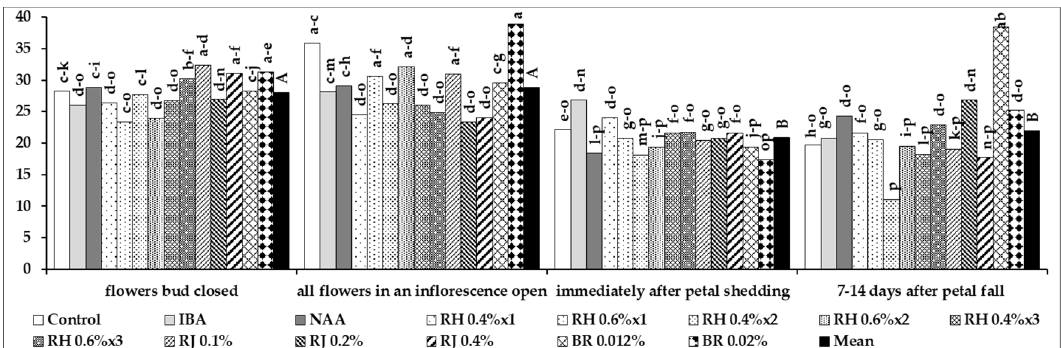
Figure 6. The influence of rooting enhancers on total leaf area (cm 2 ) in Rosa ‘Maiden’s Blush’ cuttings harvested in four phenological stages of shoot. Control—the control cuttings; IBA 0.4%—Ukorzeniacz A aqua (0.4% IBA); NAA 0.2%—Ukorzeniacz B aqua (0.2% NAA); RH 0.4%×1, RH 0.6%×1—watering with 0.4% or 0.6% Bio Rhizotonic (10 mL) after planting; RH 0.4%×2, RH 0.6%×2—watering with 0.4% or 0.6% Bio Rhizotonic (10 mL) after planting and 10 days later; RH 0.4%×3, RH 0.6%×3—watering with 0.6% Bio Rhizotonic (10 mL) after planting, 10 and 20 days later; RJ 0.1%, RJ 0.2%, RJ 0.4%—watering with 0.1%, 0.2%, or 0.4% Root Juice™ (10 mL) after planting; BR 0.012%, BR 0.02%—watering with 0.012% or 0.02% Bio Roots (10 mL) after planting. Different small letters indicate significant interactions between phenological stage and treatment (two ‐ way ANOVA). Different capital letters indicate significant differences between phenological stages. The Duncan’s test ( α = 0.05) was used.